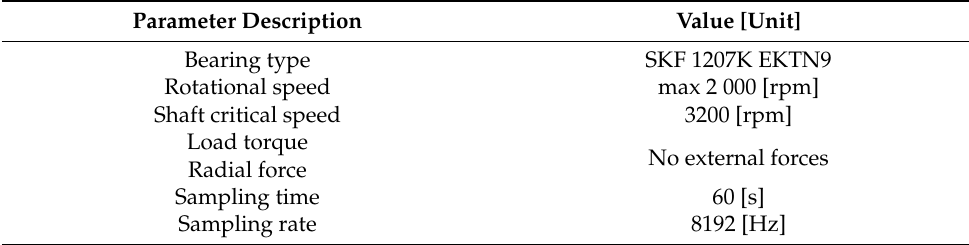
Figure 2. Measurement test rig: 1 – ball bearings (a – on the brake side, b – on the drive side); 2 – motor; 3 – shaft; 4 – mass disc; 5 – accelerometers; 6 – eddy current sensors; 7 – electromagnetic brake; 8 – control panel. Table 2. Experimental test stand parameters.